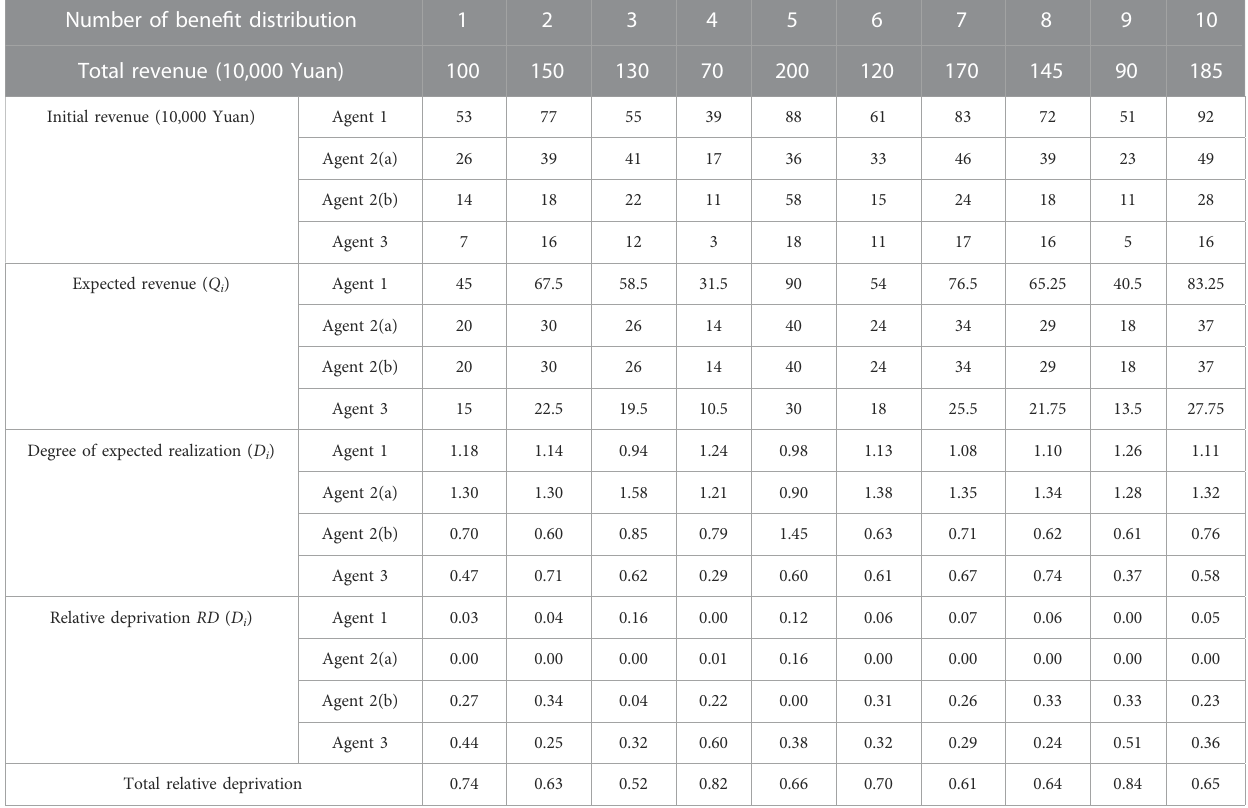
TABLE 1 10 groups of bene fi t distribution of four companies in the initial state. Number of bene fi t